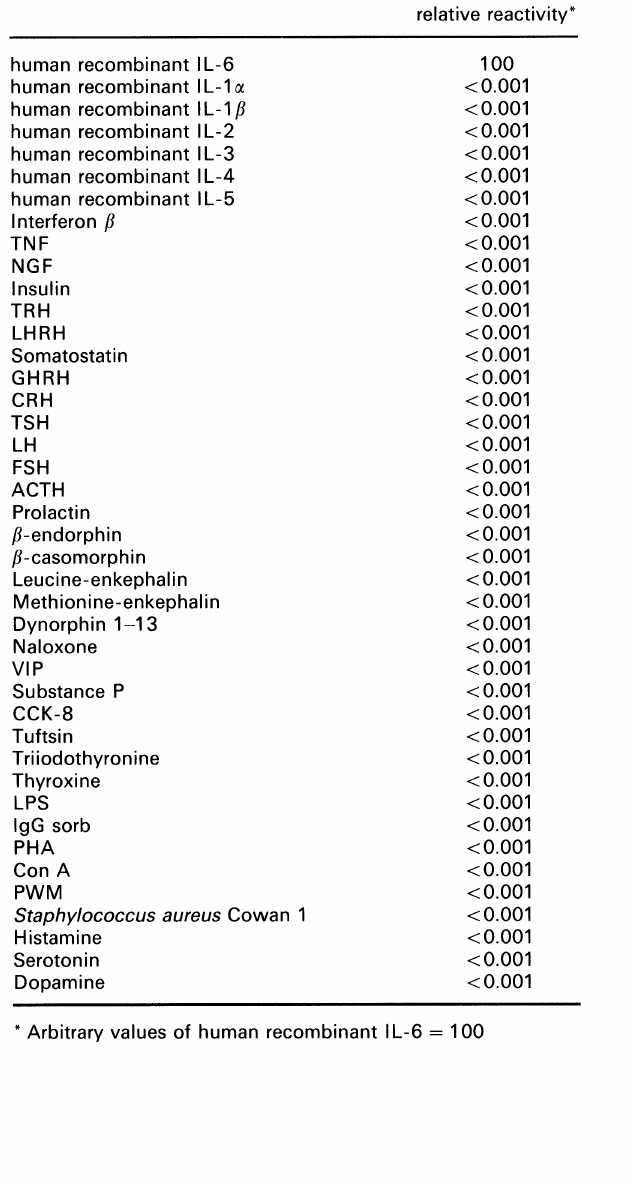
Table 2. Relative reactivity of cytokines, growth factors, hormones, peptides and lectins in L-6 radioimmunoassay relative